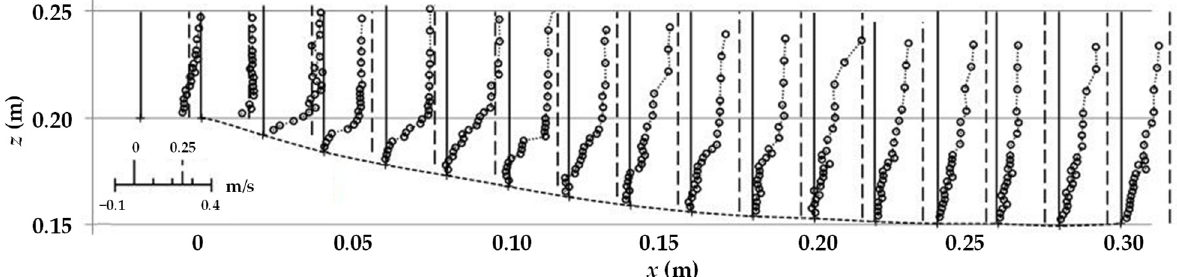
Figure 6. Distribution of mean flow velocity in the scoured hole (modified from [18]).